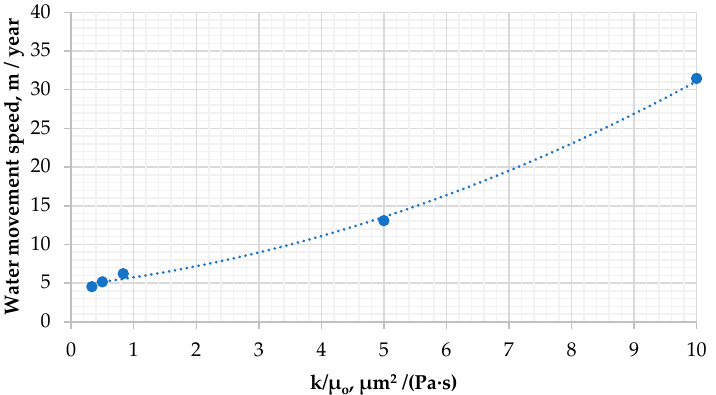
Figure 3. Dependence of the water movement speed on the mobility factor (distance of 400 m, P inj − P bot = 8 MPa).